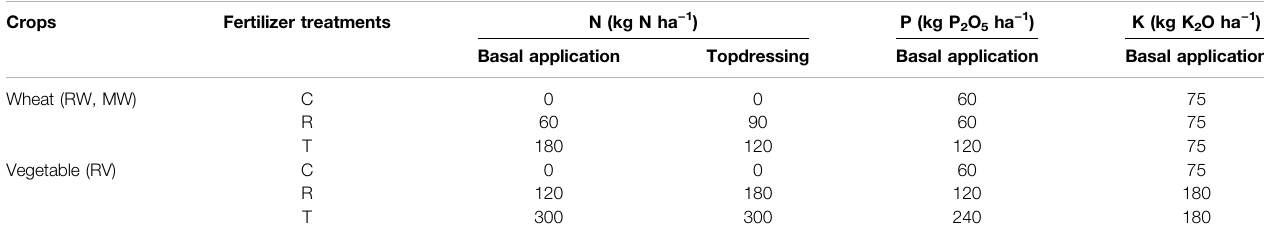
TABLE 2 | Fertilizer applications in the wheat/vegetable season. Crops